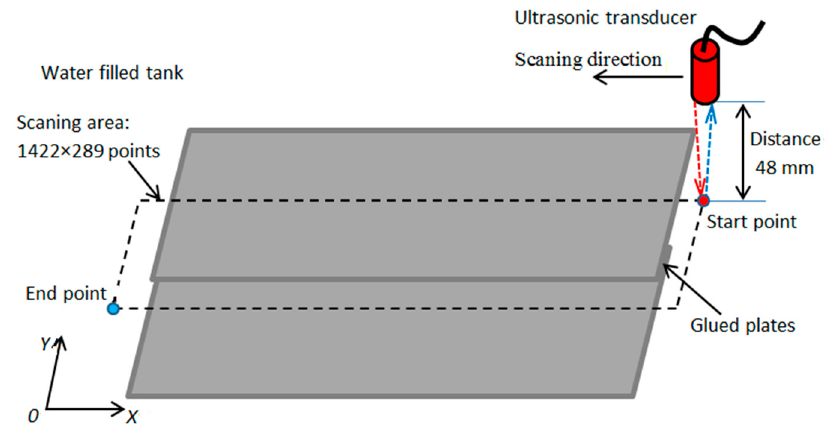
Figure 3. Experimental set-up of ultrasonic pulse-echo immersion.